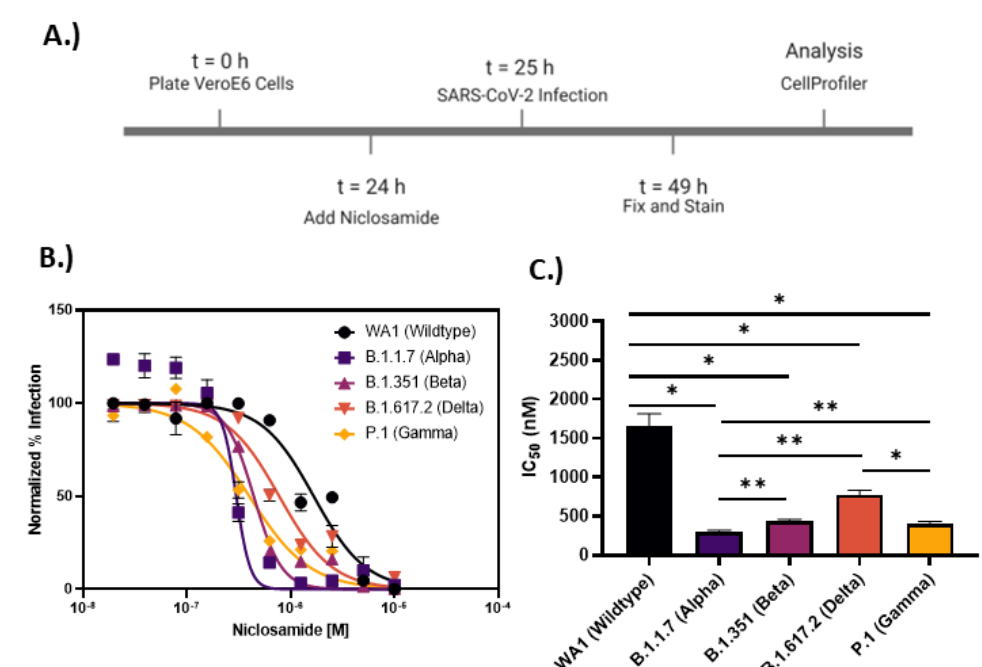
Figure 2. Niclosamide potency is SARS-CoV-2 variant dependent. ( A ) Assay timeline for 24-h infection experiment. The assay window was shortened to reduce niclosamide toxicity. ( B ) 10-point 2-fold concentration–response curves for niclosamide against the different SARS-CoV-2 variants of concern (MOI = 0.1 for each variant) with a top concentration of 10 µ M. Curves were fitted with GraphPad Prism 9 software using a semi-log 4-parameter variable slope model. Data for each variant were normalized to the average percent infected of its respective viral control. Data points represent mean ± SEM for n = 3 replicates. ( C ) IC 50 values for niclosamide potency against SARS-CoV-2 variants of concern. Values were extracted from curve fitting using GraphPad 9 and include SEM error bars (WA1: 1664 ± 149 nM, B.1.1.7: 298 ± 23 nM, B.1.351: 440 ± 21 nM, B.1.617.2: 774 ± 58 nM,